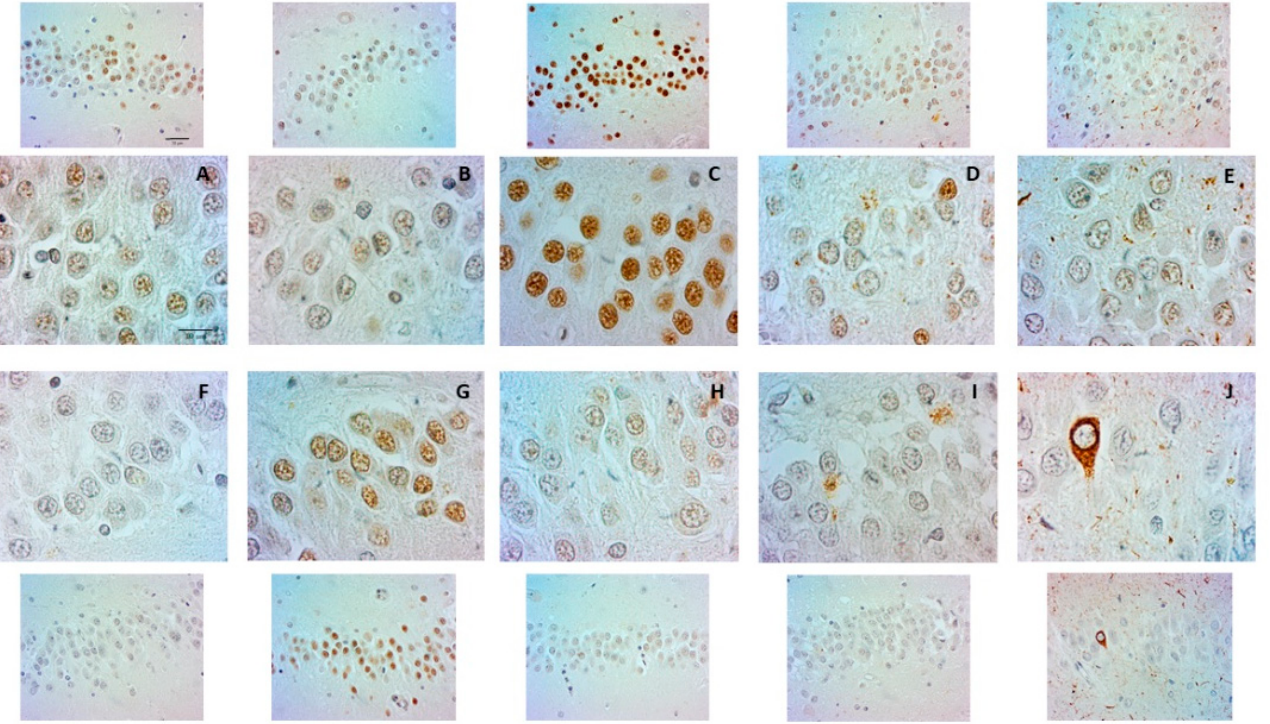
Figure 3. AT100 and AT8 in DG granule cells. Detail of AT100 transition from nuclei ( A – C ) to cytoplasm and extracellular sites in AD III–VI ( D , E ). Scale bar: 10 µm. Lower magnification microphotographs (upper panels) show the panoramic view of AT100 immunopositivity. Scale bar: 20 µm. AT8 is scarce in adult DG ( F ) and shows a strong nuclear increase in senile DG ( G ). Nuclear positivity gradually disappears from AD I–II to AD V–VI ( H – J ), and even an NFT can be observed ( J ). Lower magnification microphotographs (lower panels) show panoramic views of AT8 immunopositivity.